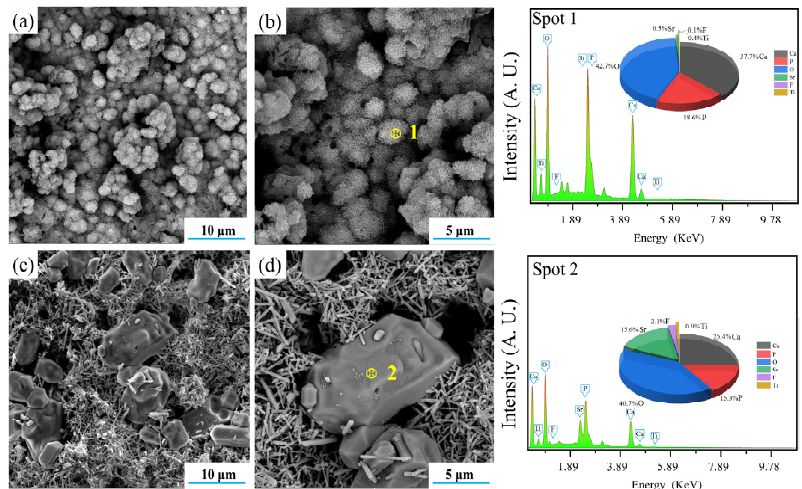
Figure 15. SEM–EDS analyses of ( a , b ) the deposition product (D50) and ( c , d ) the calcination product (C50).